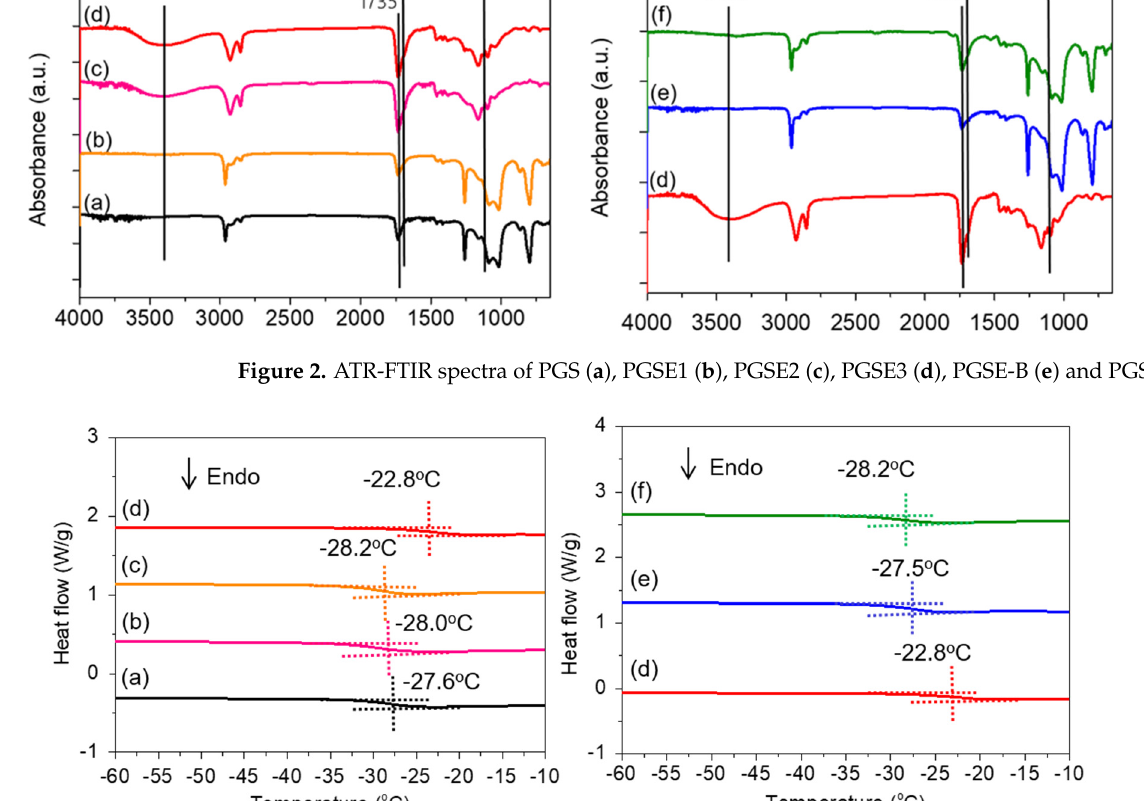
Figure 2. ATR-FTIR spectra of PGS ( a ), PGSE1 ( b ), PGSE2 ( c ), PGSE3 ( d ), PGSE-B ( e ) and PGSE-Z ( f ).